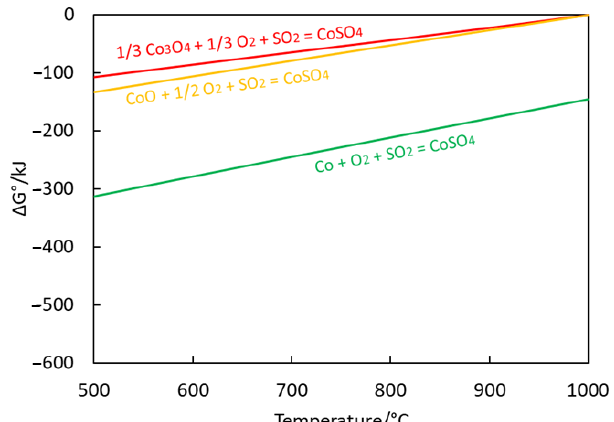
Figure 13. Gibbs free energy formation of cobalt sulfate from metallic cobalt and cobalt oxides.